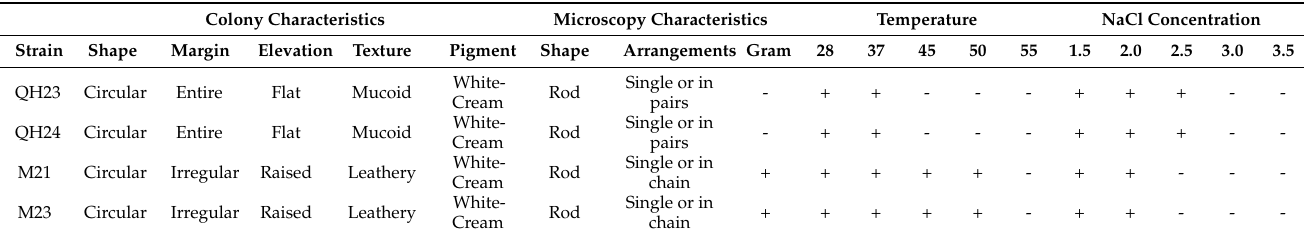
Table 1. Morphological and physiological characterizations of bacterial strains.